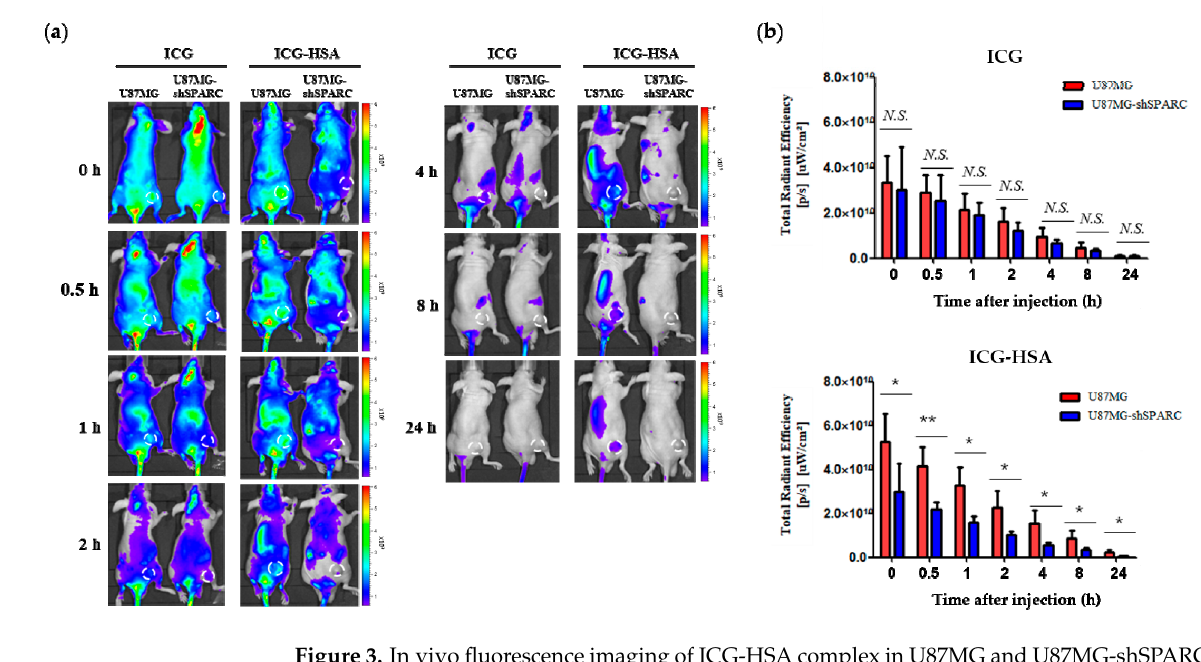
Figure 3. In vivo fluorescence imaging of ICG-HSA complex in U87MG and U87MG-shSPARC tumor- bearing mice. ( a ) Fluorescence images at different time points; 0, 0.5, 1, 2, 4, 8, and 24 h. The white circle indicates the tumor region; ( b ) NIR fluorescence intensity of the tumor region. Fluorescence signals from tumors were acquired through ROI analyses (n = 3). N.S. non-significant difference. *: p < 0.05, **: p < 0.01.